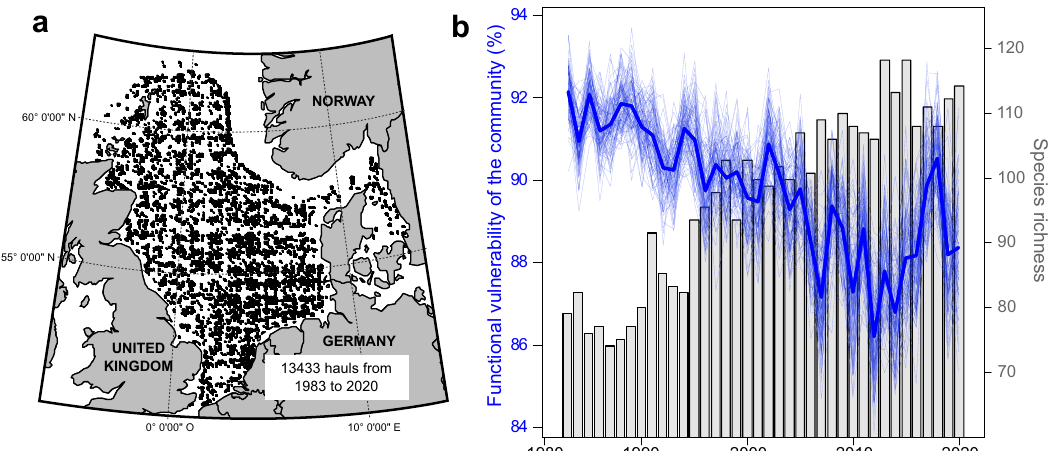
Fig. 2 | Sampling effort of the IBTS survey and temporal dynamics of vulner- abilityintheNorthSea fi shcommunities.a Spatialandtemporalcoverageofthe North Sea International Bottom Trawl Survey (NS-IBTS) from 1983 to 2020 (each point represents a 30min haul). The background map was obtained through the